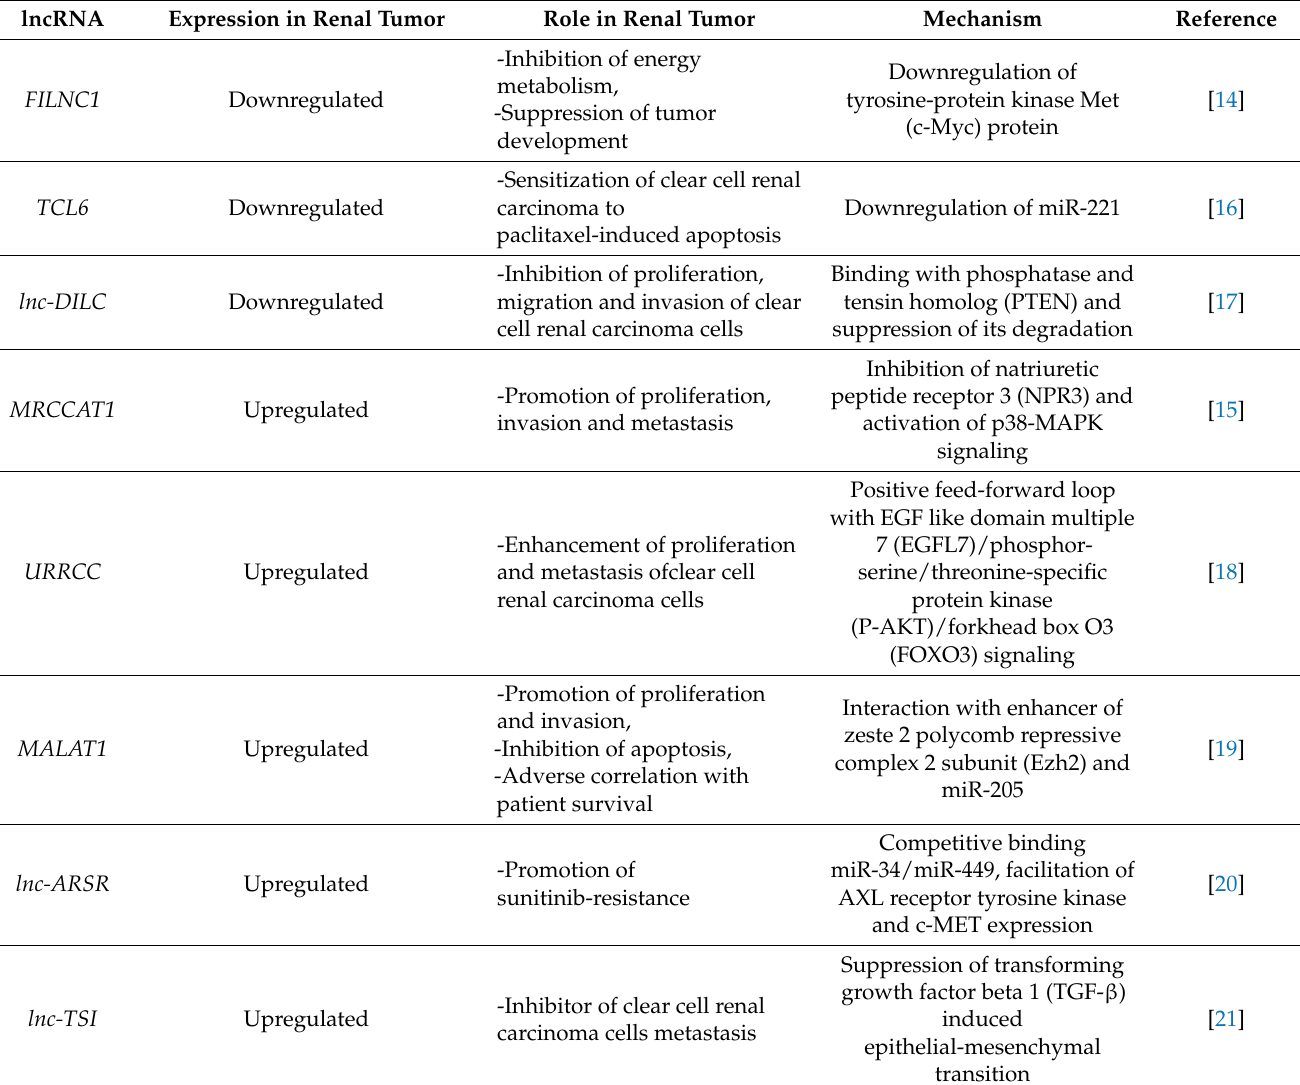
Table 1. Long non-coding RNAs and their implications in renal cell